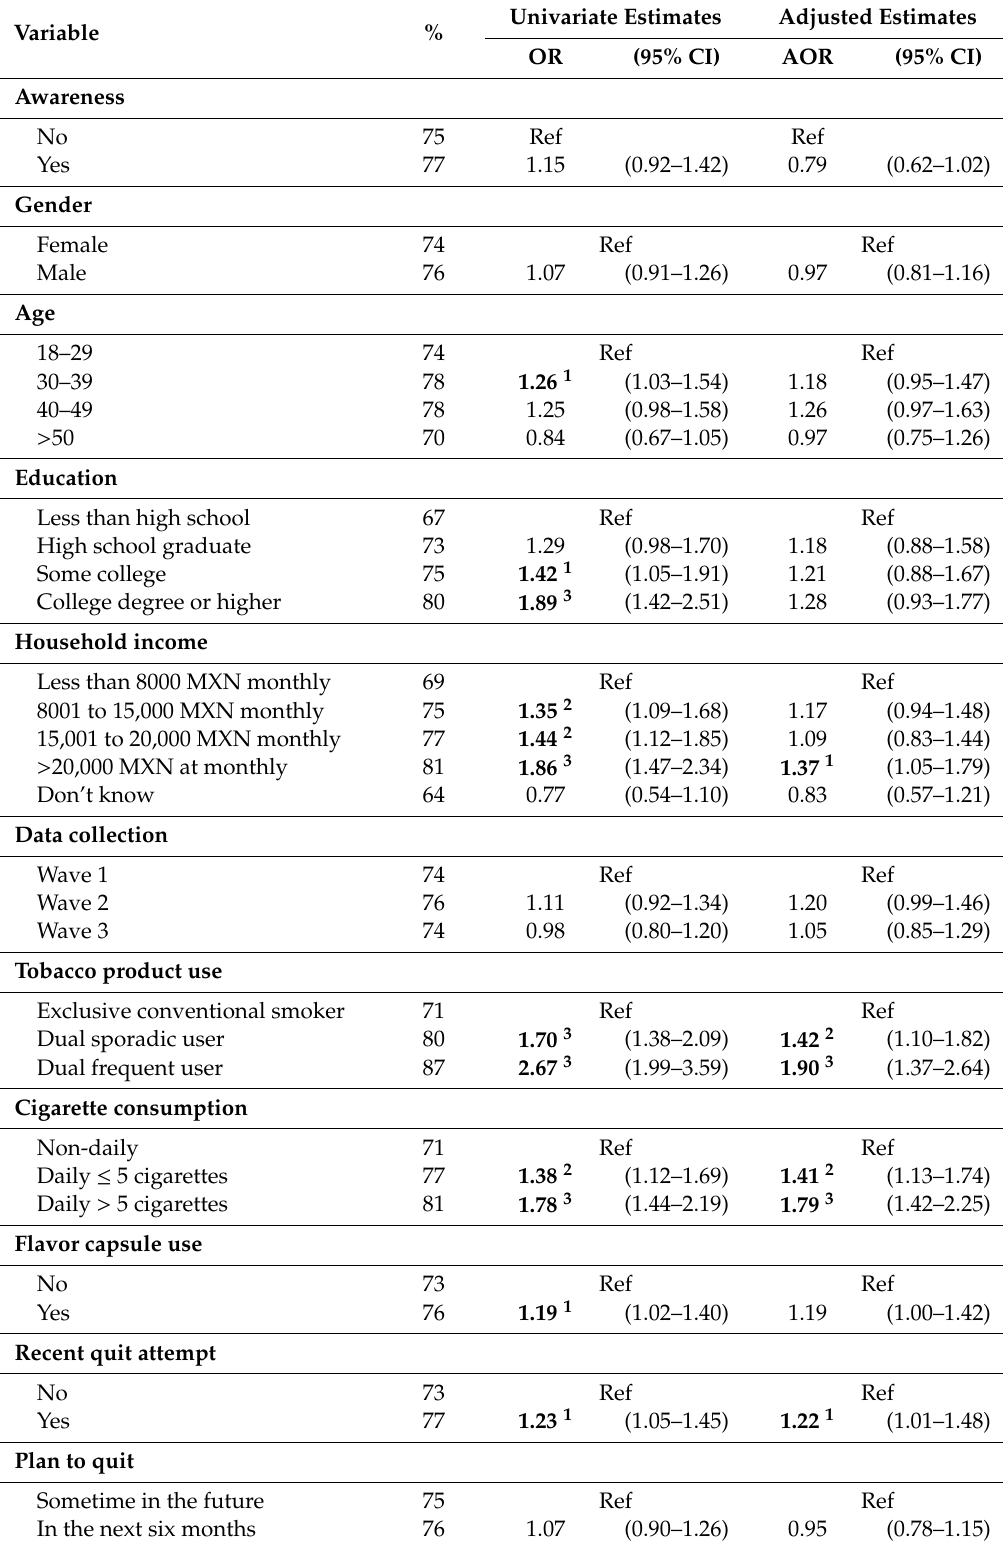
Table 4. Factors associated with the interest in trying IQOS among adult smokers ( n =